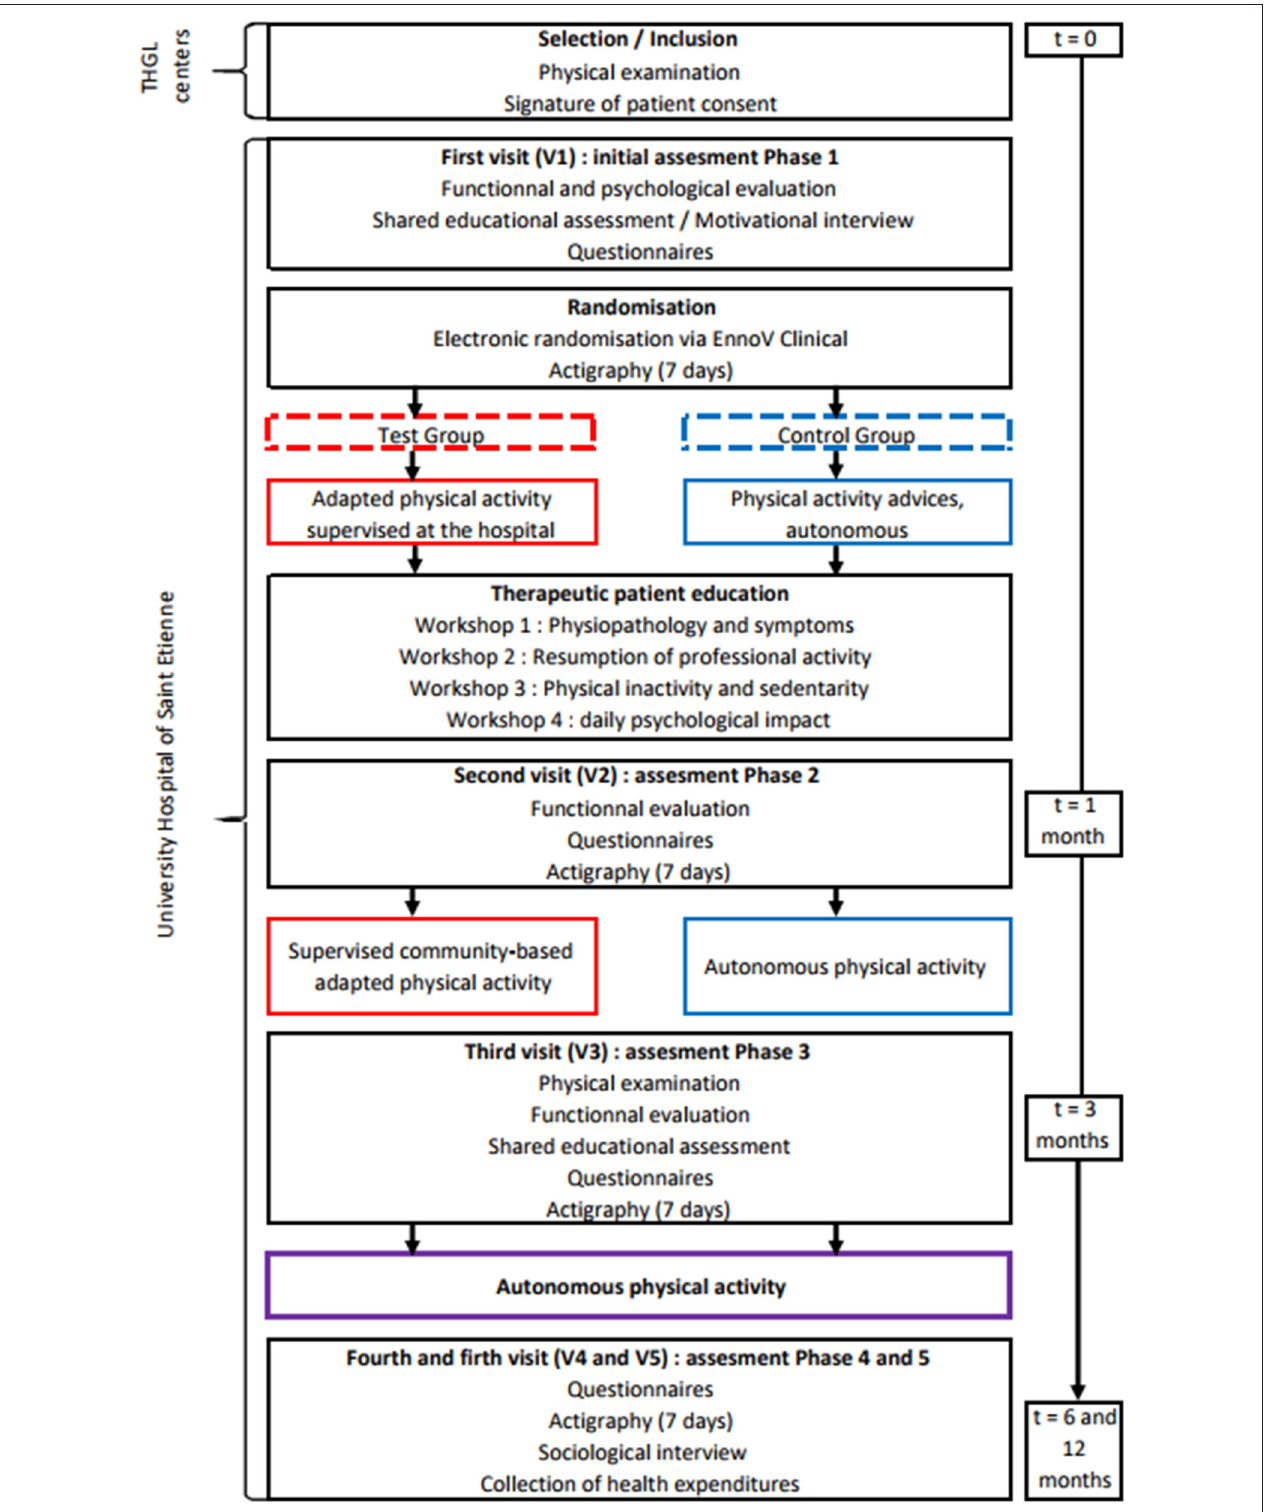
FIGURE 2 | Study design of FIMOUV. THGL, Territorial Hospital Group of Loire.